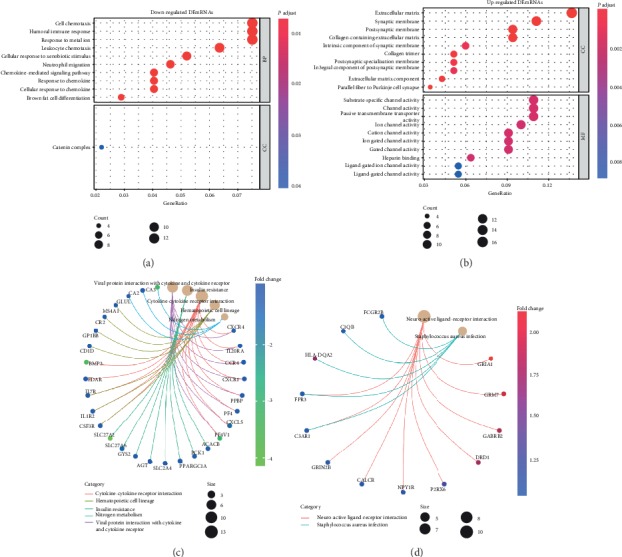
GO and KEGG analyses for significant DEmRNAs in GSE133099. The bubble charts present GO analysis results of downregulated (a) and upregulated mRNAs (b). The network charts present KEGG analysis results of downregulated (c) and upregulated mRNAs (d).